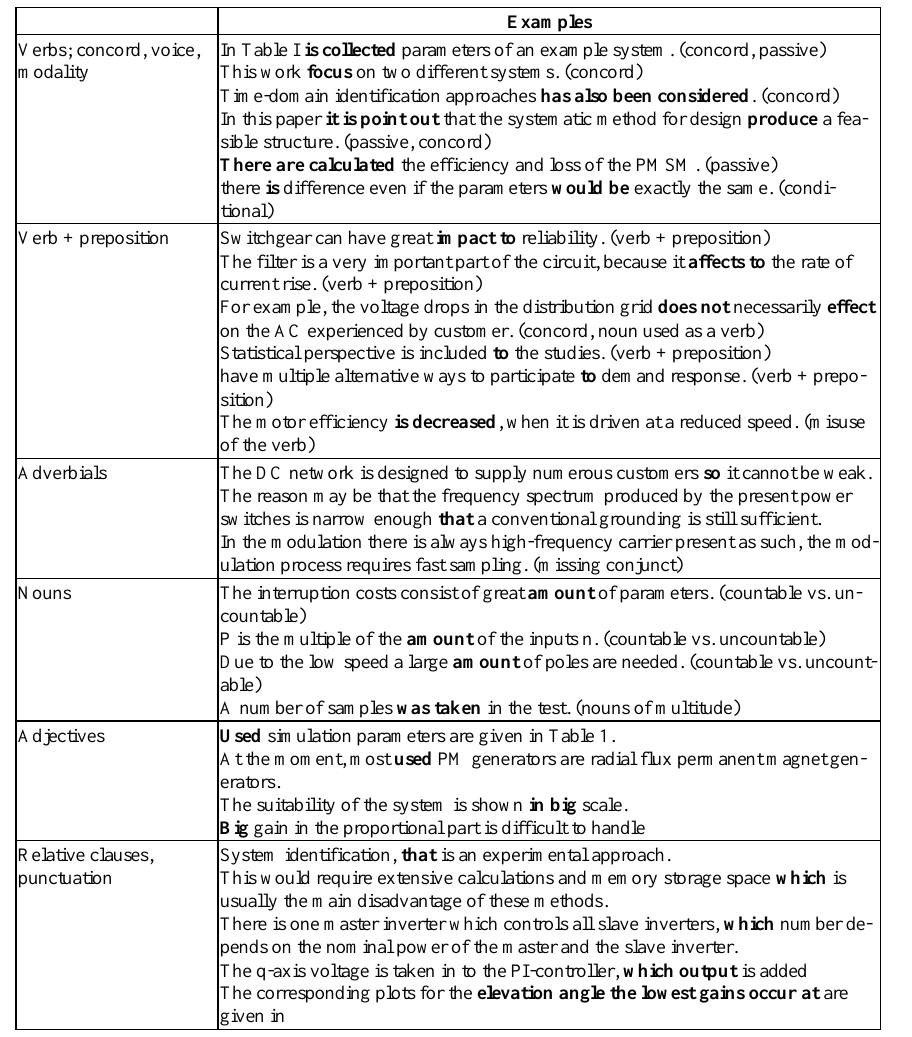
Table 1. Examples of typical grammatical